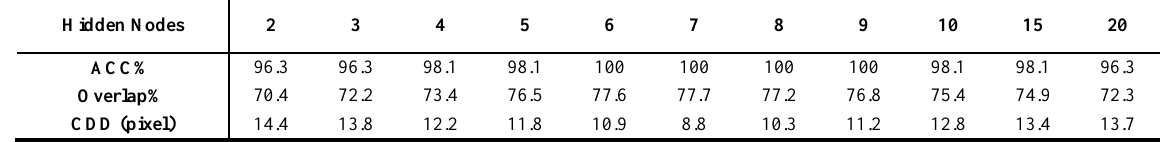
Table 1. Results obtained for proposed method for different numbers of hidden neurons in ANN. Hidden